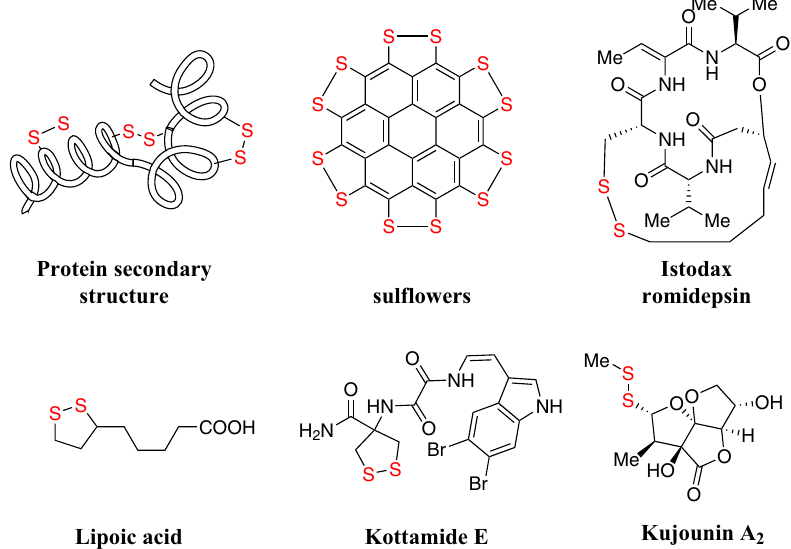
Fig. 1 Representative biorelevant disul fi de compounds. The importance of disul fi des in life science, natural products, and other fi